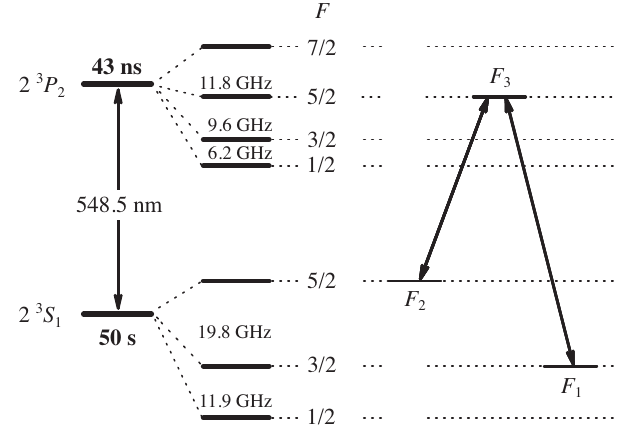
FIG. 1. Level scheme and hyperfine structure of the 2 3 S 1 → 7 Li þ . The F ¼ 5 = 2 ↔ F ¼ 5 = 2 ↔ F ¼ 2 3 P 2 transition in 2 3 1 3 = 2 Λ transition investigated in this work is shown on the